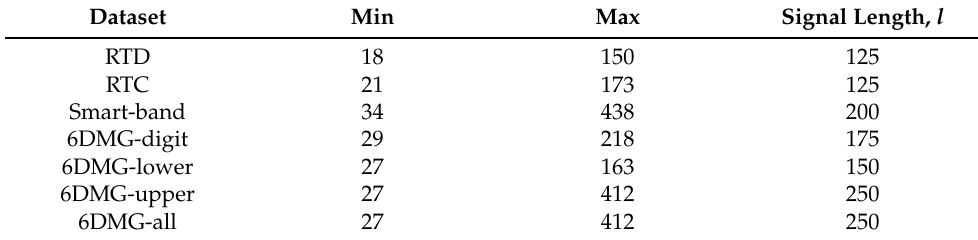
Table 5. Selected signal length, l for all